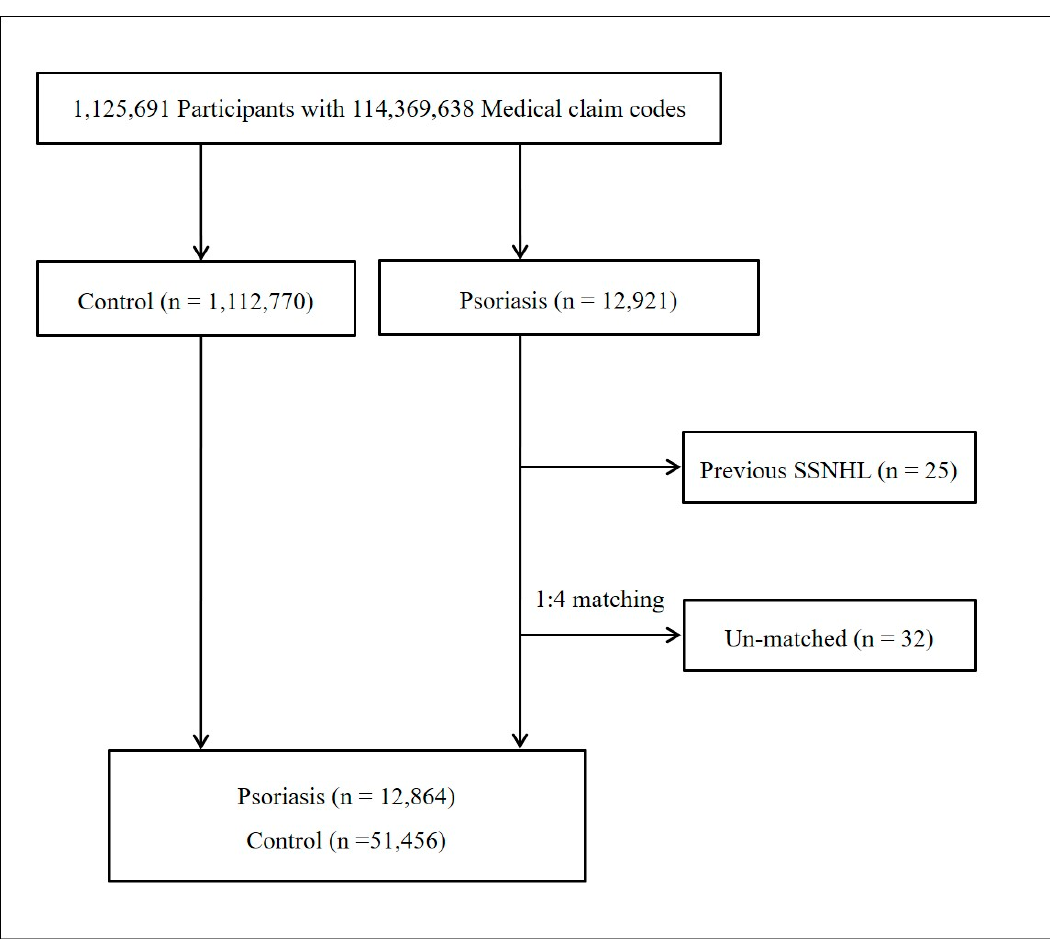
Figure 1. A schematic illustration of the participant selection process used in the present study. Of 1,125,691 participants, 12,864 psoriasis participants were matched with 51,456 control participants for age, group, sex, income group, region of residence, and past medical histories. for age, group, sex, income group, region of residence, and past medical